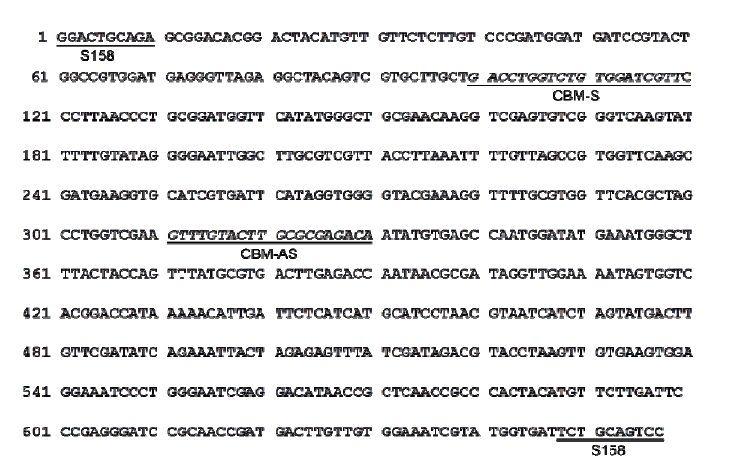
Figure 2. Nucleotide sequence of the RAPD amplicon CBM08; the RAPD primers (a pair of S158) and SCAR primers (CBM-S and CBM-AS) were